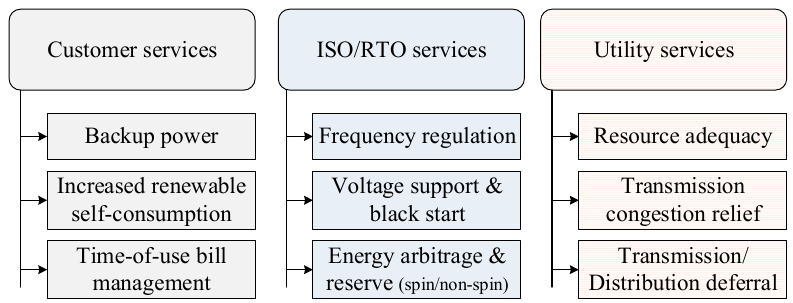
Figure 1. An overview of different demand response (DR) programs.